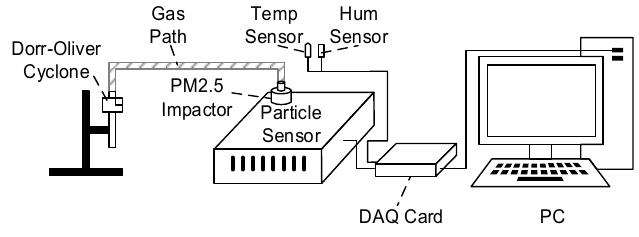
Figure 8. Schematic diagram of the experimental system.